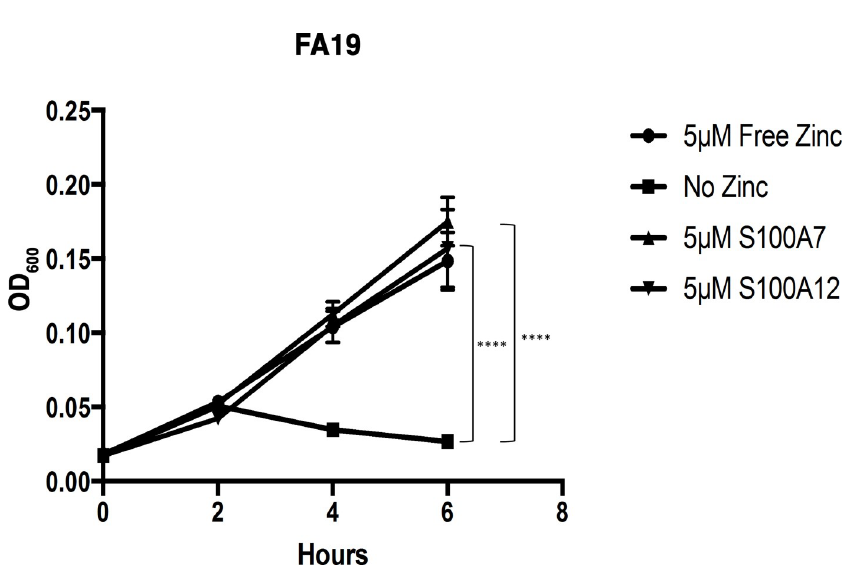
Fig 4. Neisseria gonorrhoeae strain FA19 utilizes S100A7 and S100A12 as a sole zinc source. Wild-type N . gonorrhoeae strain FA19 was grown in Zn-limited conditions in defined media (CDM), which was supplemented with growth premix containing either ZnSO 4 , S100A7, S100A12, or no zinc. Growth was measured by OD 600 readings every 2 h for 6 h total. The graph demonstrates means and SD for N = 3 independent experiments. A 2-way repeated measures ANOVA with Tukey’s correction was performed for all means, with significance at 6 h shown. � , P � . 05; �� , P � .005; ��� , P � .0005; ���� , P � .0001.